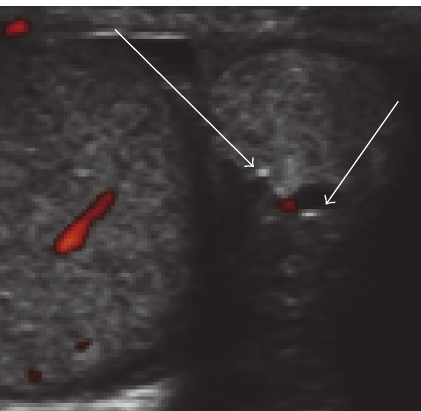
Figure 2: Yellowish uncapsulated mass (arrow) with maximum diameter of 13 mm located next to the tail of the epididymis.